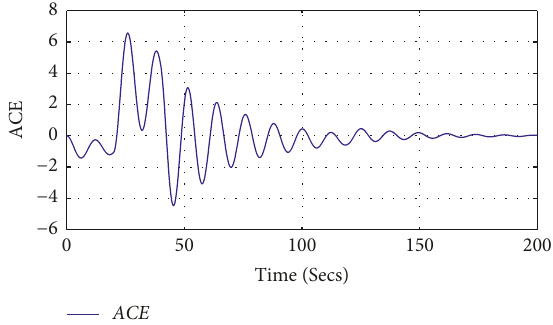
Figure 4: Evaluation of ACE in equation (11) in Theorem 2. Table 7: The control gain K for fixed d Theorem 3.